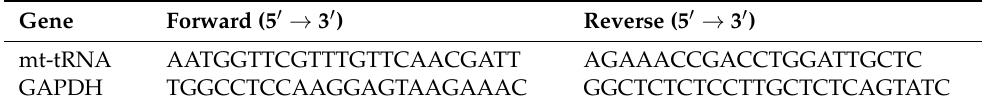
Table 4. List of the gene-specific primers for the real-time PCR analysis.